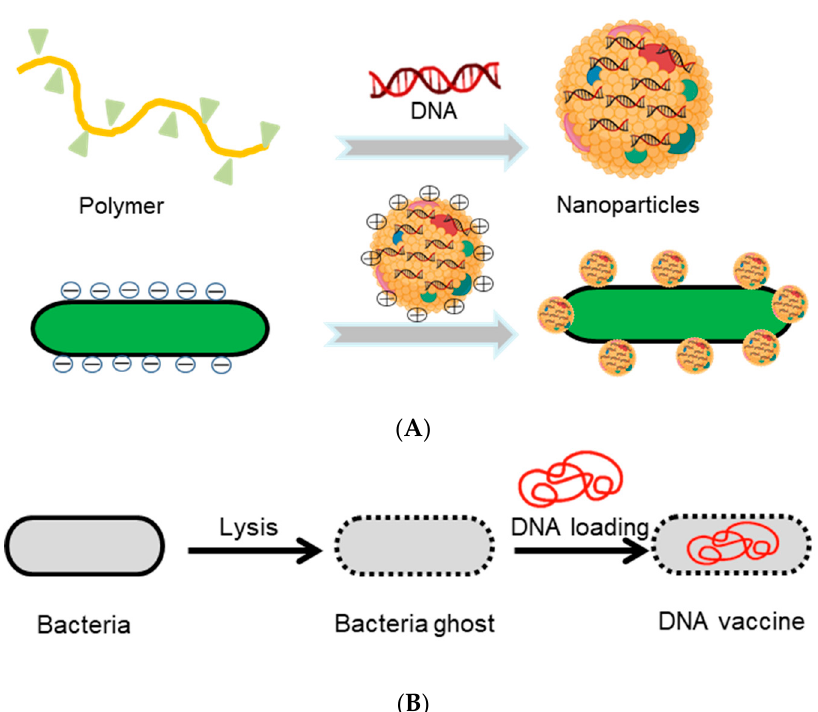
Figure 3. Engineered bacteria for the oral delivery of nucleic acids. ( A ) DNA nanoparticle-decorated bacteria as an oral vaccine for cancer therapy. Adapted from [74], published by American Chemical Society, 2015. ( B ) DNA vaccines orally delivered by bacterial ghost for HIV. Adapted from [78], published by Elsevier BV, 2012.